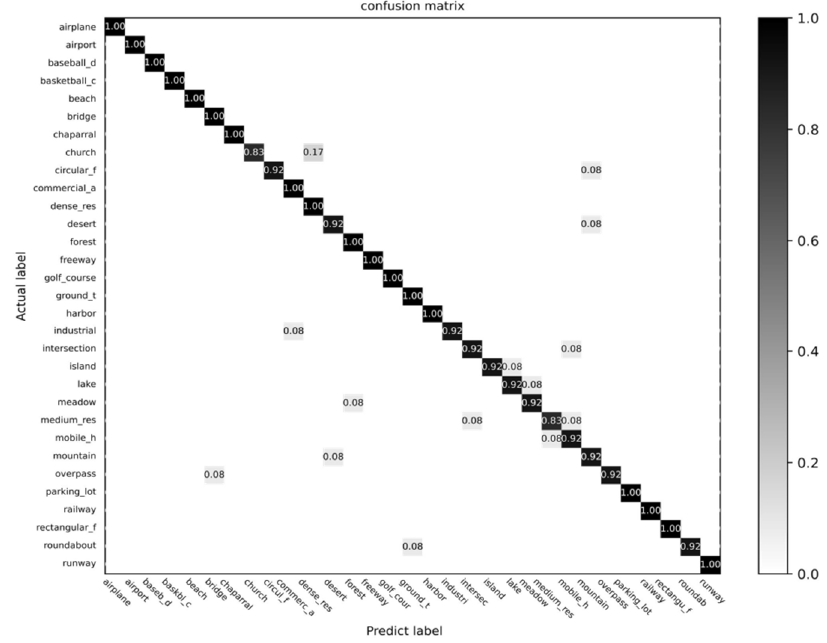
Figure 9. Confusion matrices of the OPTIMAL-31 dataset.